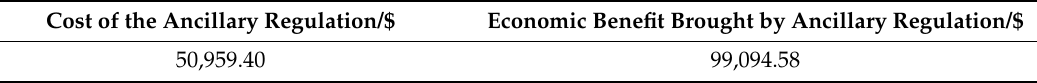
Table 5. Cost and benefit of the ancillary